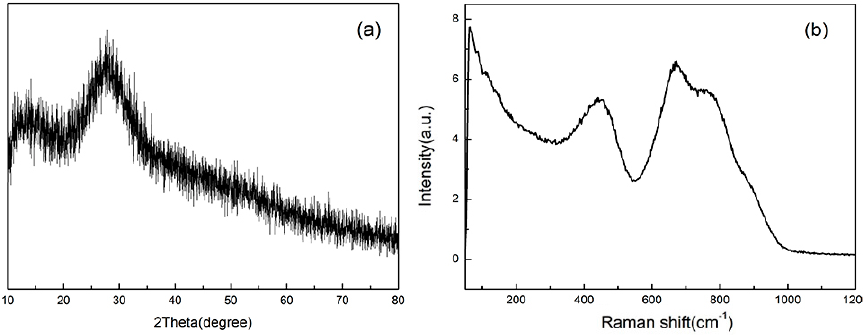
Figure 2. ( a ) The XRD pattern of TZNb glass; ( b ) Raman spectrum of undoped TZNb glass.